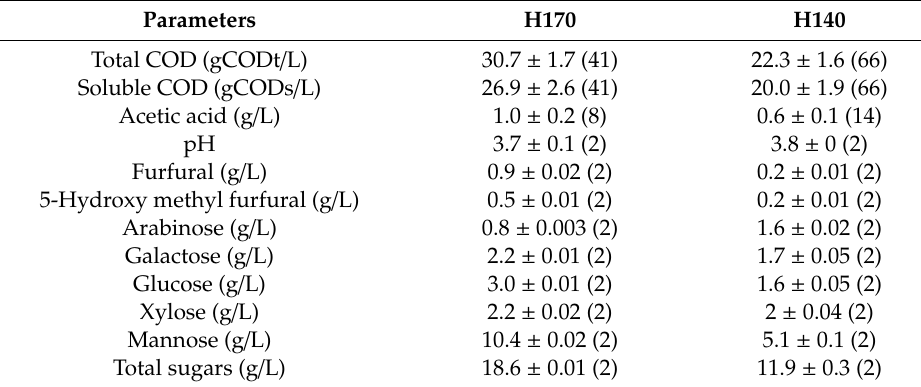
Table 6. Characteristics of hydrolysate pretreated at 140 ◦ C and 170 ◦ C (Average values ± standard deviation (n, number of